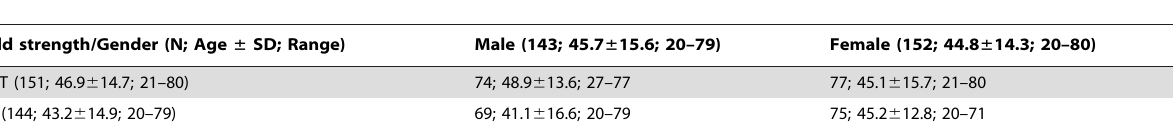
Table 1. Demographic information for the sample of 295 controls split into both genders and field strengths.